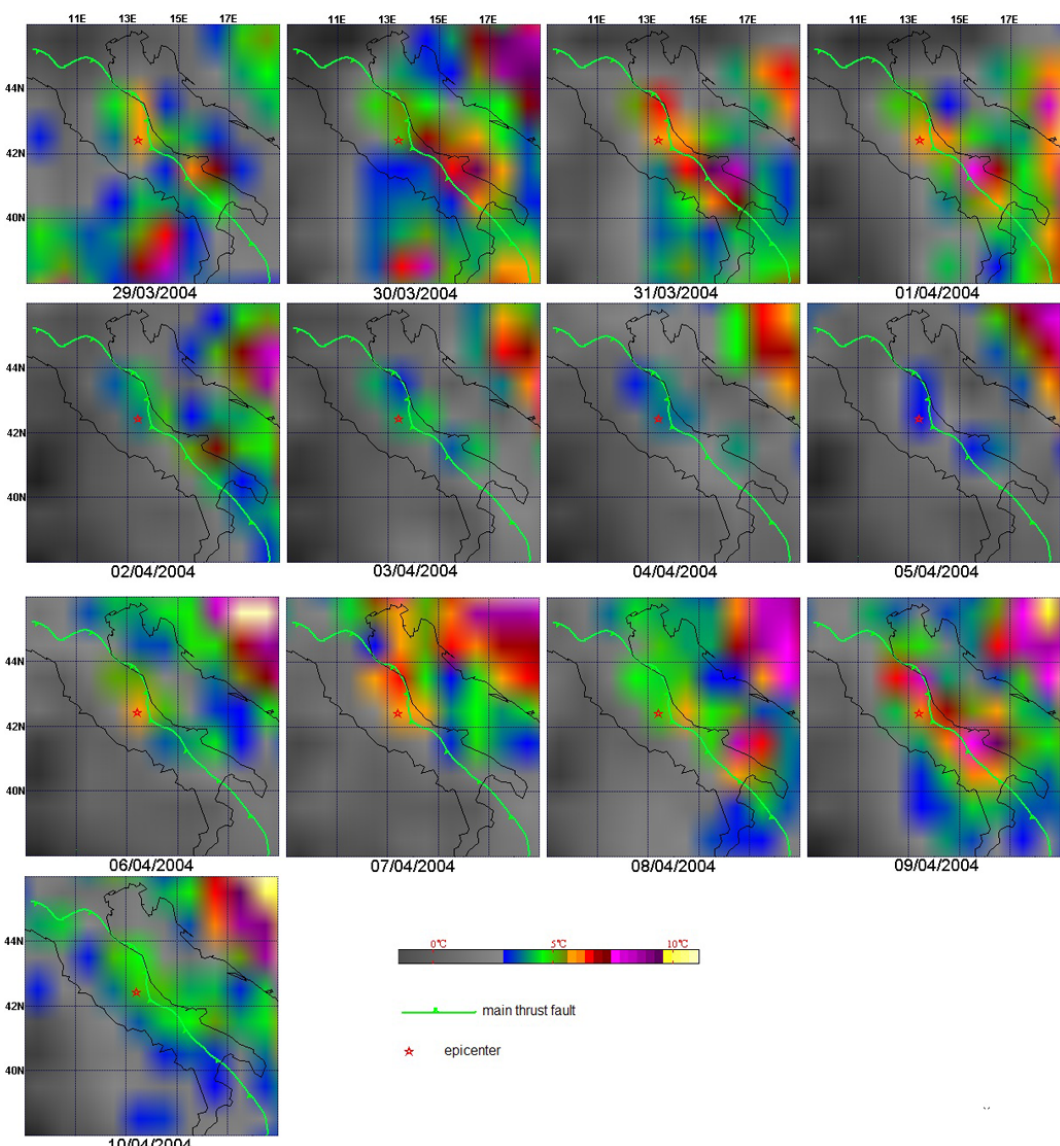
Fig. 3. Spatial-time evolution of the temperature changing based on the NCEP data (all at 00:00UTC) for the Abruzzo Earthquake in April